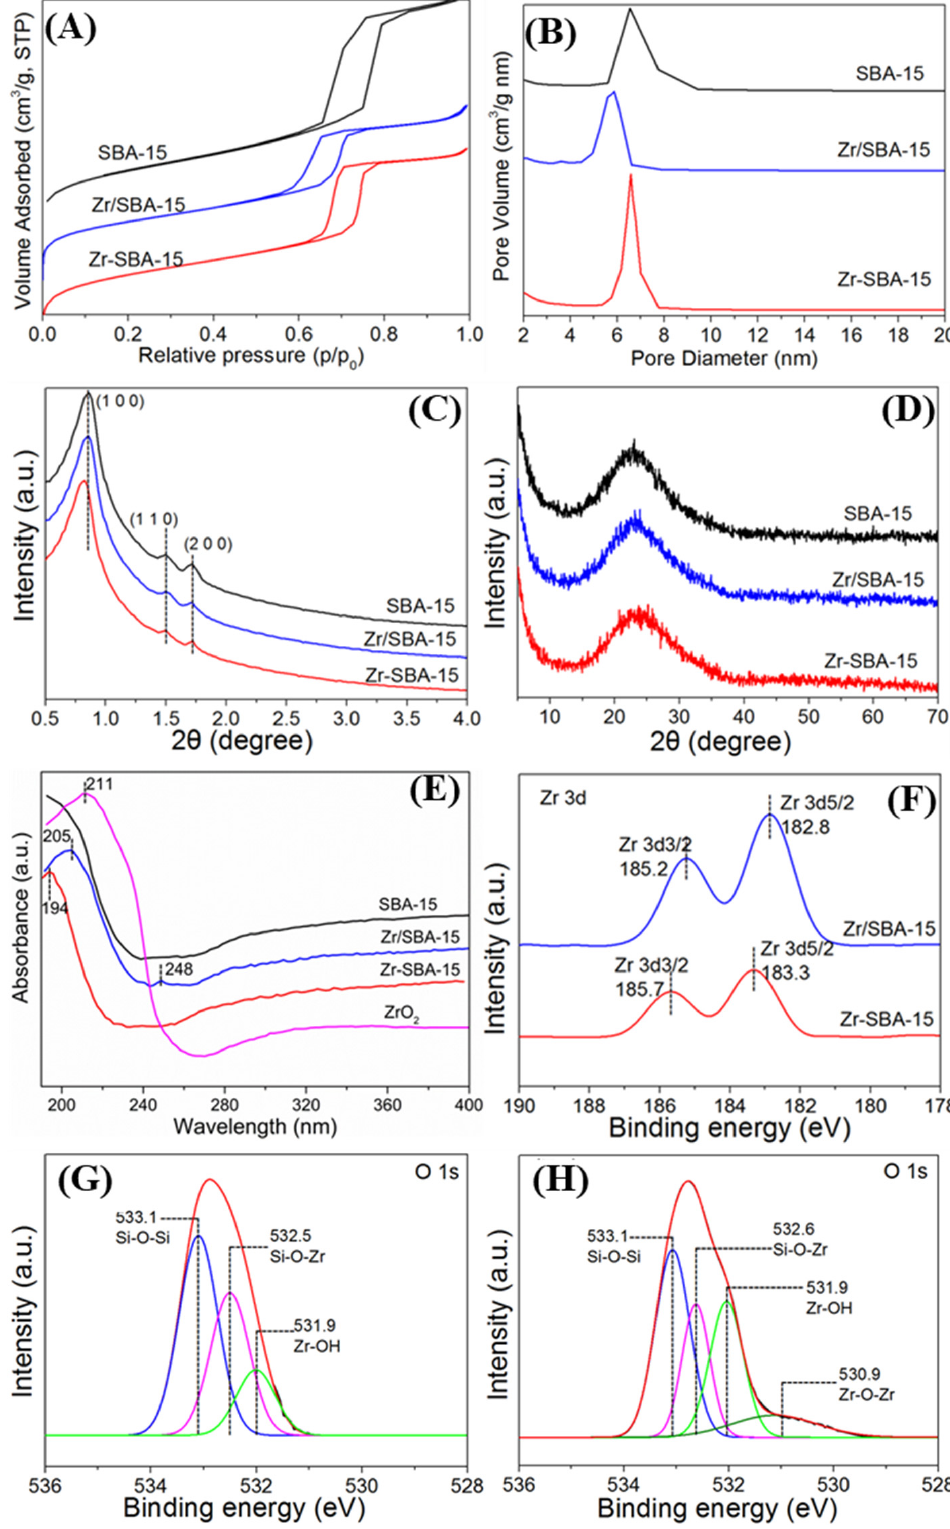
Figure 1. Nitrogen adsorption–desorption isotherms ( A ), pore-size distribution ( B ), low-angle XRD patterns ( C ), and wide-angle XRD patterns ( D ) of the SBA-15, Zr/SBA-15, and Zr-SBA-15 catalysts. DR UV-vis ( E ) and XPS spectra of Zr 3d ( F ), for Zr/SBA-15 and Zr-SBA-15 catalysts, and XPS spectra of O 1s of Zr-SBA-15 ( G ) and Zr/SBA-15 ( H ) catalysts.